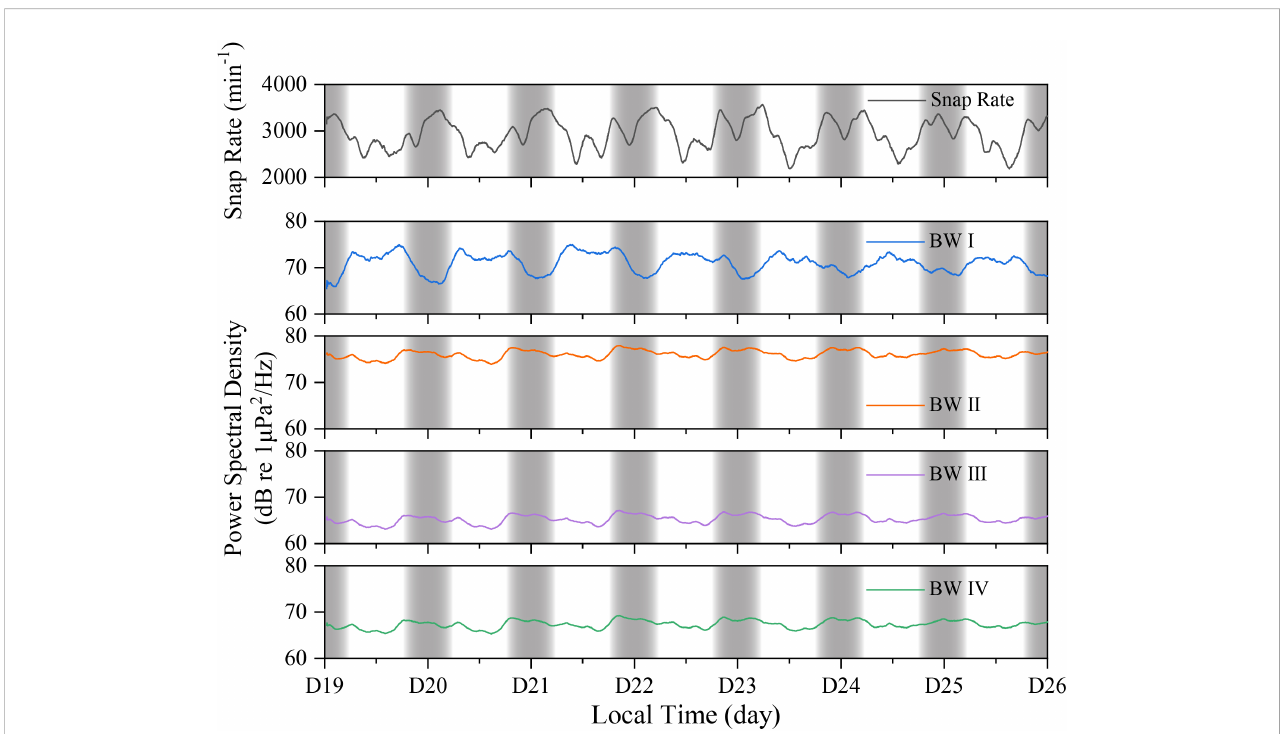
FIGURE 6 Relation between snap rate and the corresponding soundscape components at different frequency bandwidths, where BW I, BW II, BW III, and BW IV represent the mean power spectral densities (PSD) for frequency ranges of 0-1.5 kHz, 1.5-10 kHz, 10 kHz -48 kHz and 0-48 kHz. The PSD was calculated over a 2-minute window and their temporal variations were given as well. Gray bar areas de fi ne nighttime